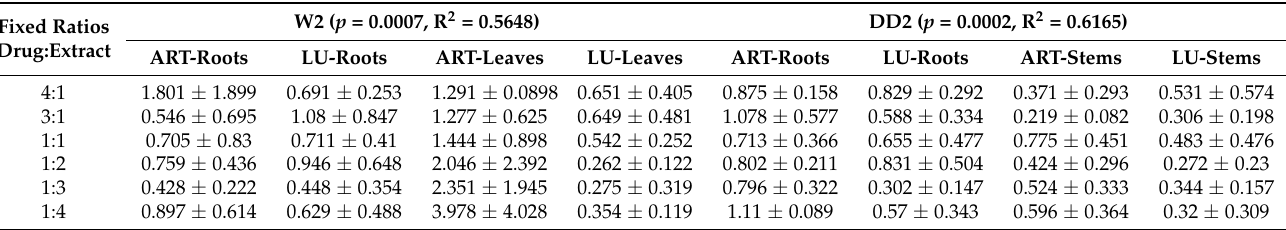
Table 2. Mean sum FIC 50 values for artemether and lumefantrine combinations with S. longipeduncu- lata against W2 and DD2 strains of P. falciparum